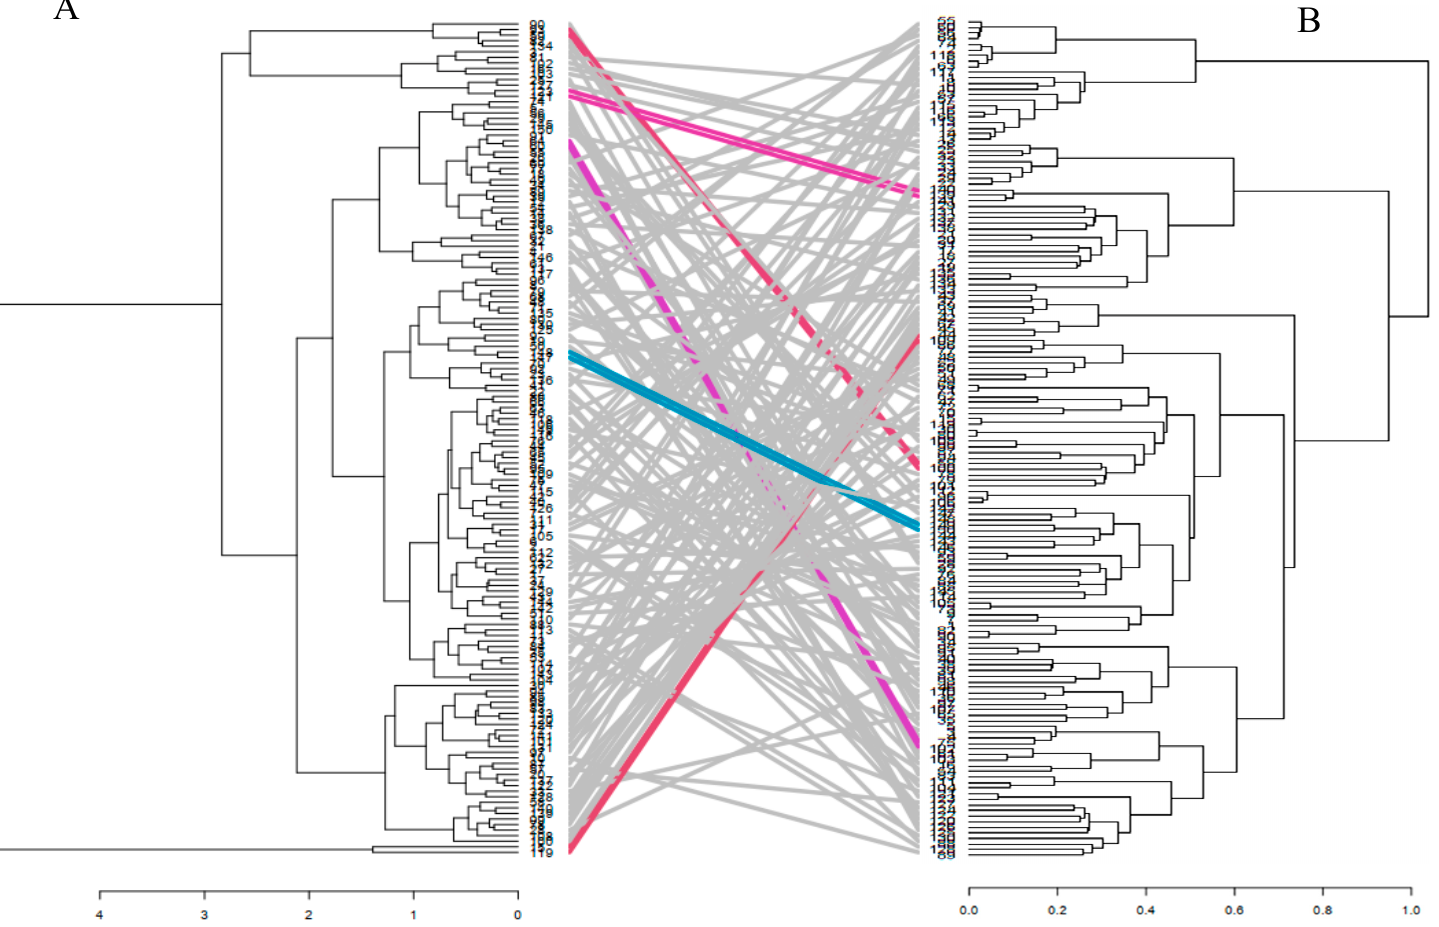
Figure 5. Comparison of hierarchical cluster analysis from the phenotypic under Striga infestation ( A ) and the genotypic ( B ). The ash lines in between the two dendrograms represent mismatched inbred lines from the genotypic to the phenotypic while the colored lines are inbred in the same position from phenotypic to the genotypic cluster.